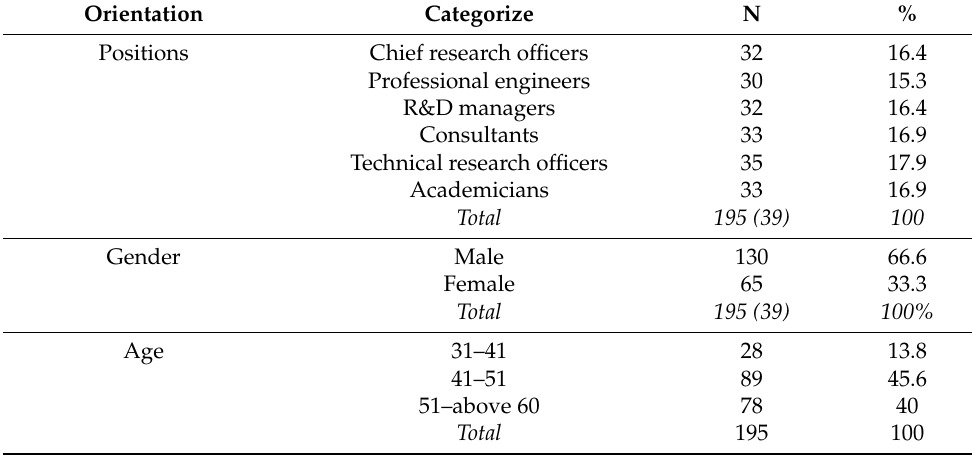
Table 2. Demographic information of the surveyed